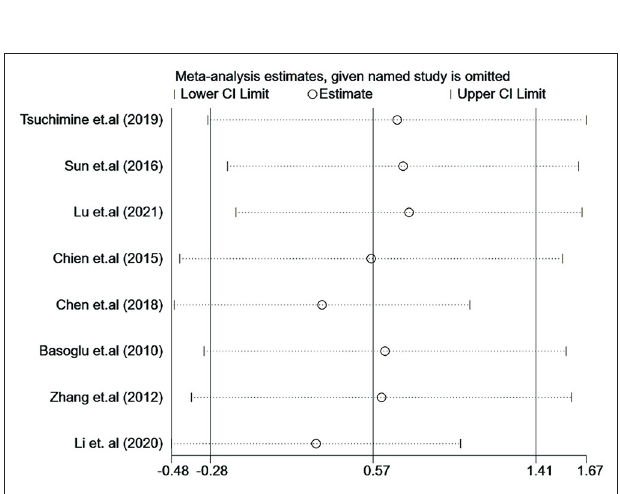
FIGURE 7 | Influence analysis of individual study on the pooled estimate for studies on the association between plasma orexin-A levels and